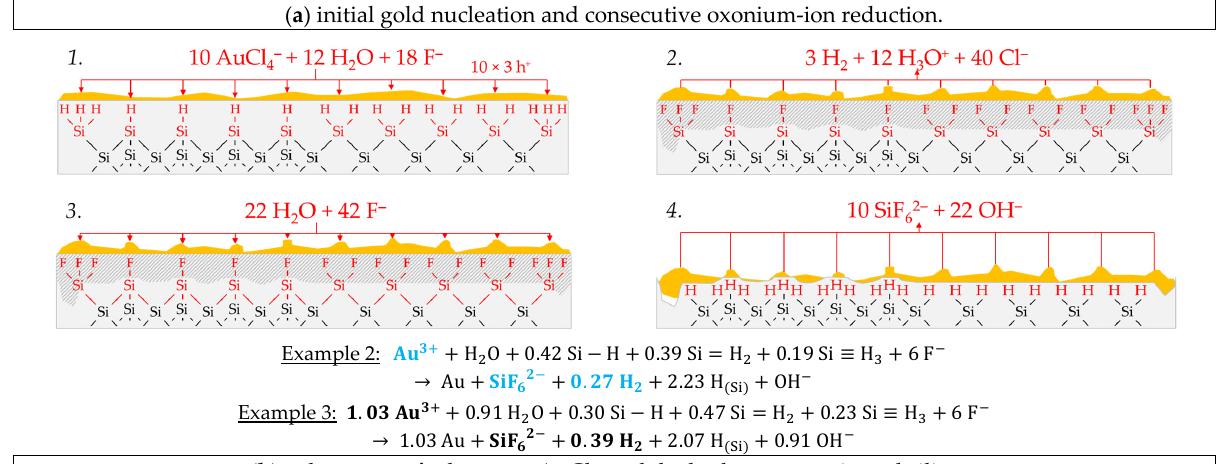
Figure 9. Schematic reaction process and balance of the gold deposition on silicon, based on the examples marked in Figure 8e,f. ( a ) Example 1: the gold nucleation and consecutive oxonium-ion reduction, ( b ) examples 2 and 3: the valence exchange between AuCl 4 − and the hydrogen-terminated silicon.